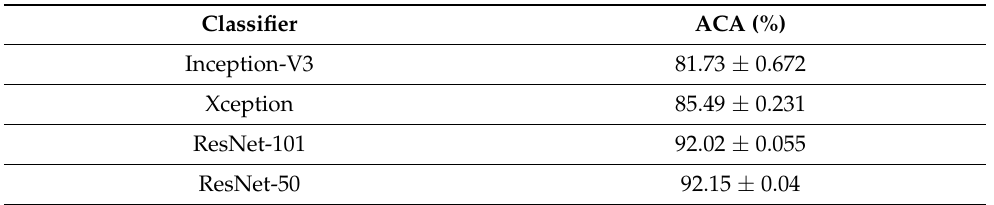
Table 1. Performance comparison of the four state-of-the-art deep learning classifiers in terms of ACA (average for 10-fold cross